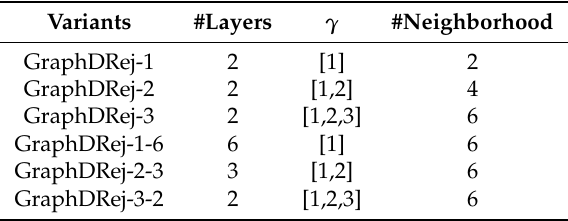
Table 5. The statistics for graphDRej variants.